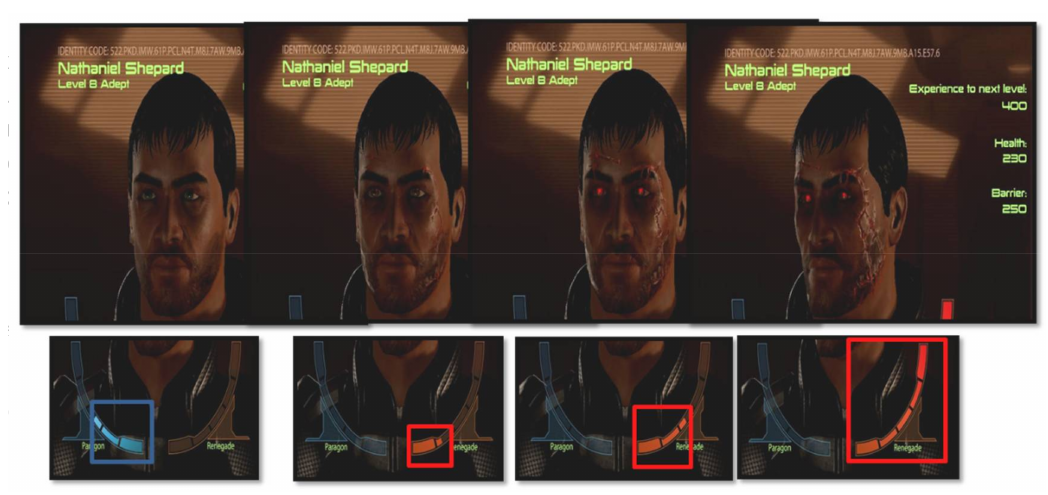
Figure 5. Scar development in relation to the “Renegade” value.